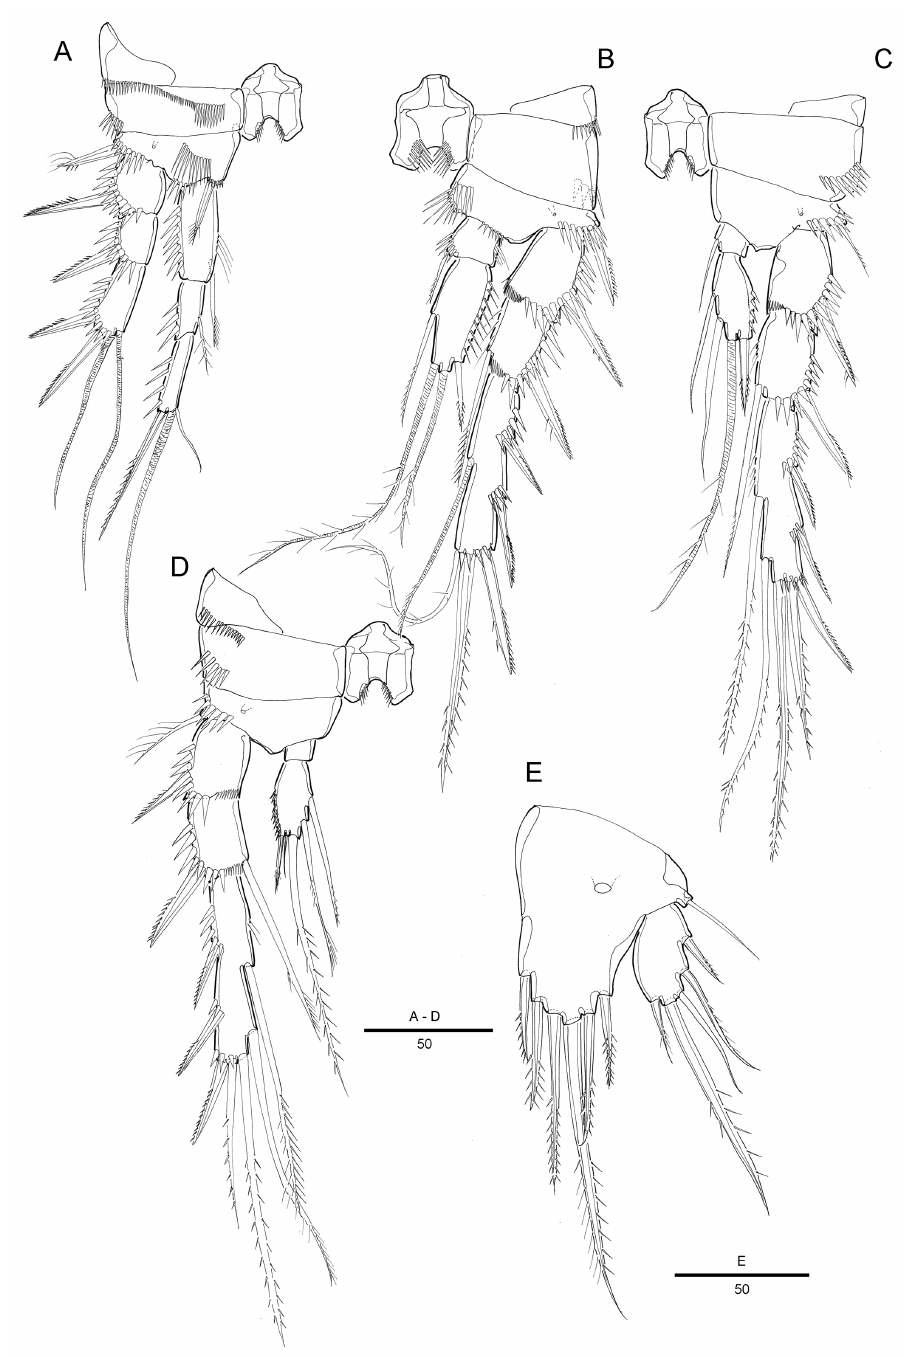
Figure 8. Attheyella ( Neomrazekiella ) tessiae sp. n. female: A P1, anterior B P2, anterior C P3, anterior D P4, anterior E P5,